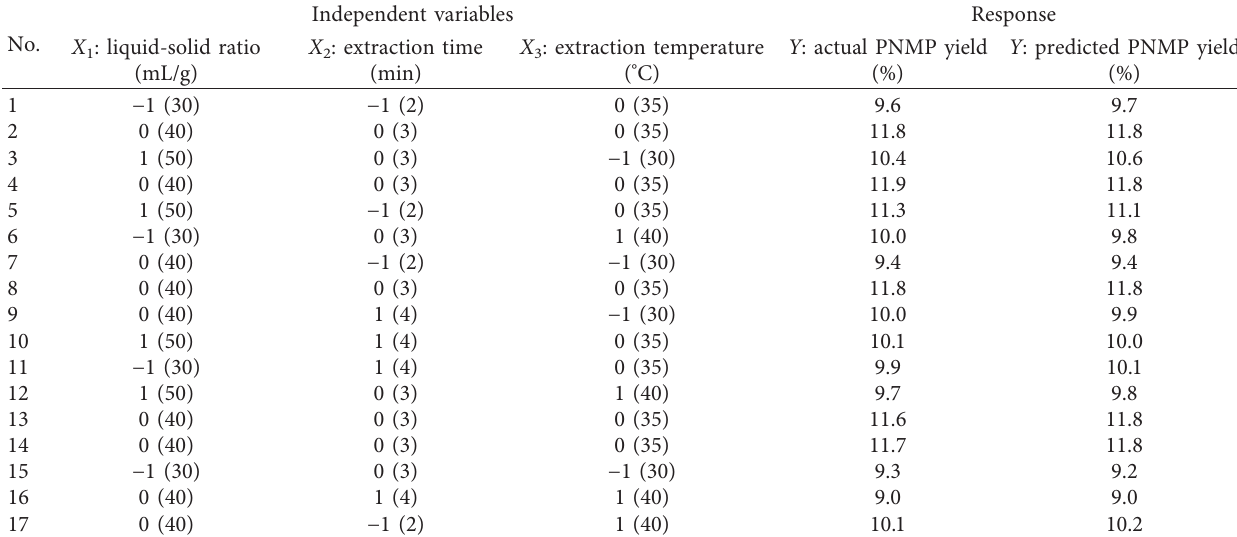
Table 1: The experimental data for the PNMP yield by homogenate extraction method using BBD design.